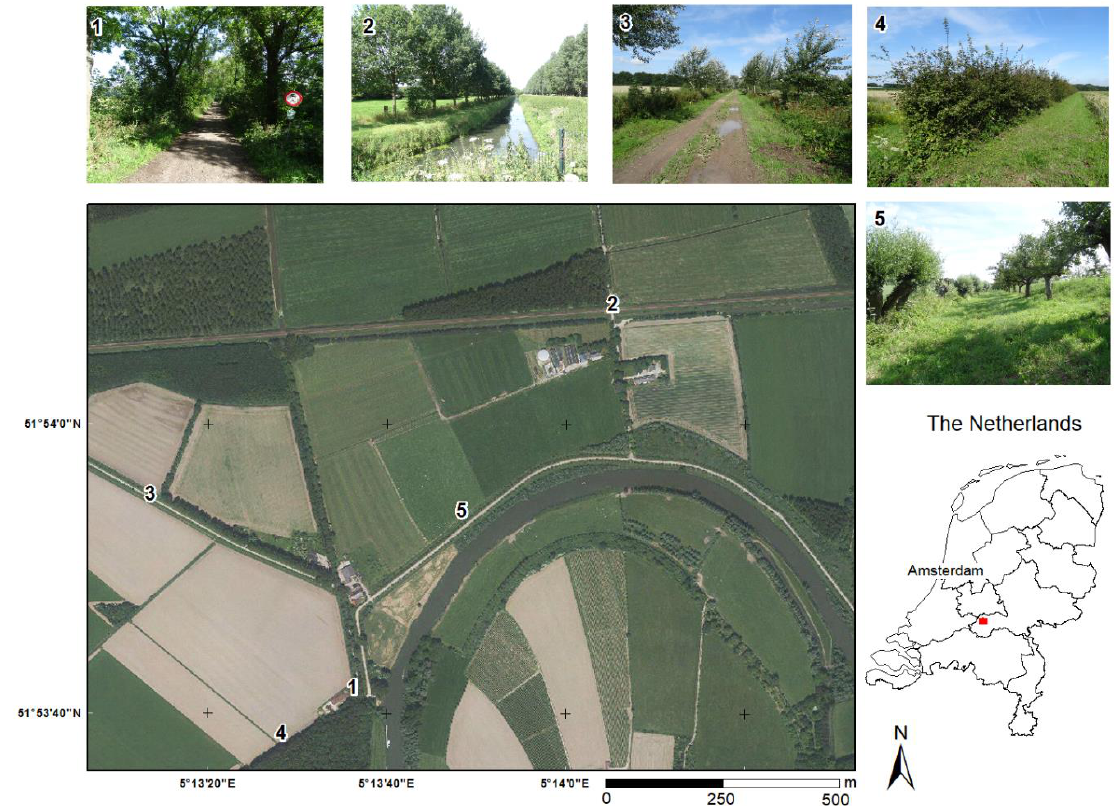
Figure 1. Location of the rural landscape in the central part of the Netherlands. The true color aerial photograph [24] shows various objects identified as agricultural fields, grasslands, bare soil, and infrastructure such as paved and unpaved roads and farmhouses. The numbered photos show a selection of the variety of linear landscape elements such as (1) green lanes (2) planted tall tree lines along ditches, (3) low and high shrubs/copse, (4) hedges and (5) rows of fruit trees and willows.